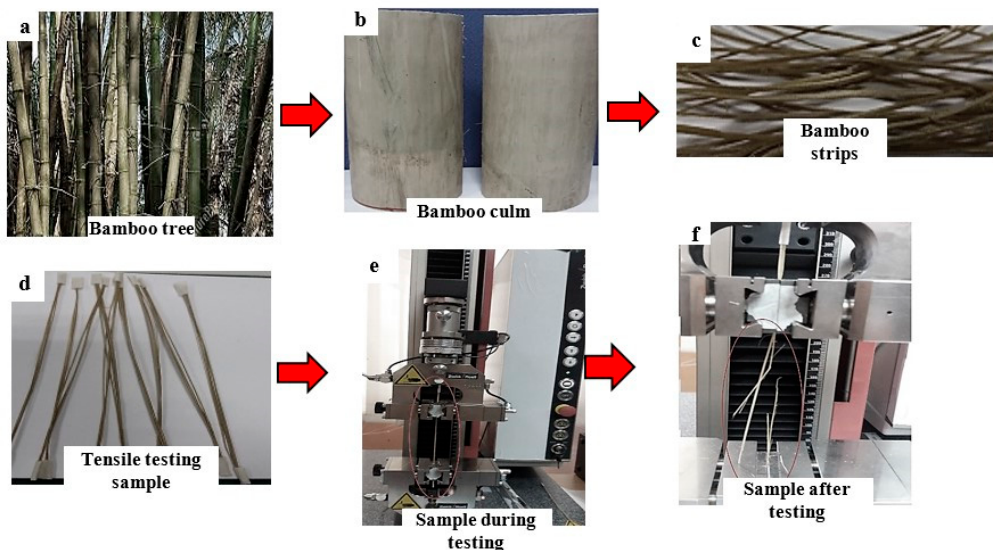
Figure 1. Schematic diagram of the preparation method used for the tensile testing samples: ( a ) the bamboo tree, ( b ) bamboo culm, ( c ) bamboo strips, ( d ) tensile testing samples, ( e ) sample during testing, and ( f ) sample after testing.